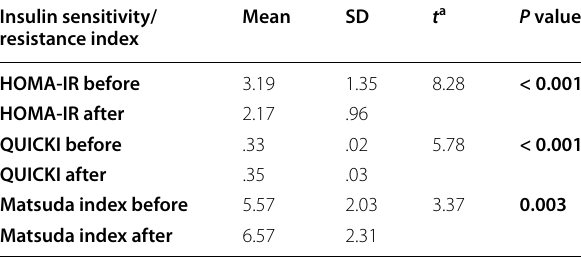
a Paired samples t